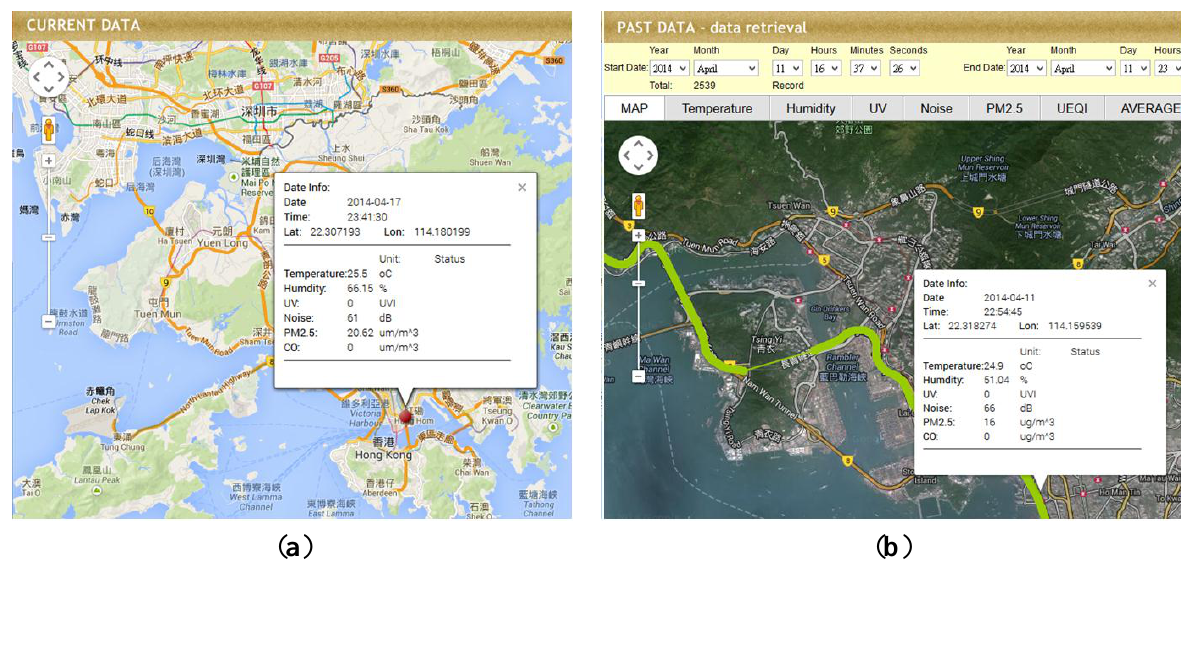
Figure 10. Web interface of ( a ) current data visualization; ( b ) archive data visualization; ( c ) data download page; ( d ) archive data of PM 2.5